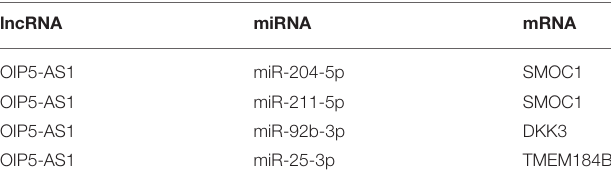
TABLE 2 | The regulatory networks between lncRNAs, miRNAs, and